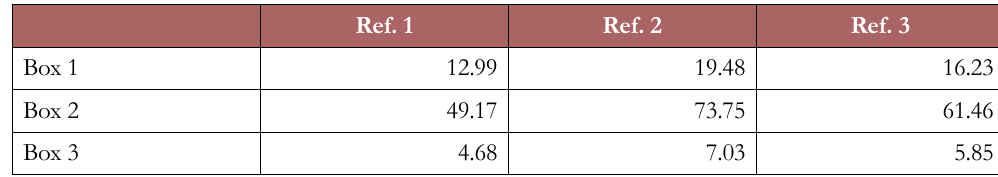
Table 3. Emissions corresponding to 1000 kg demand (kg CO